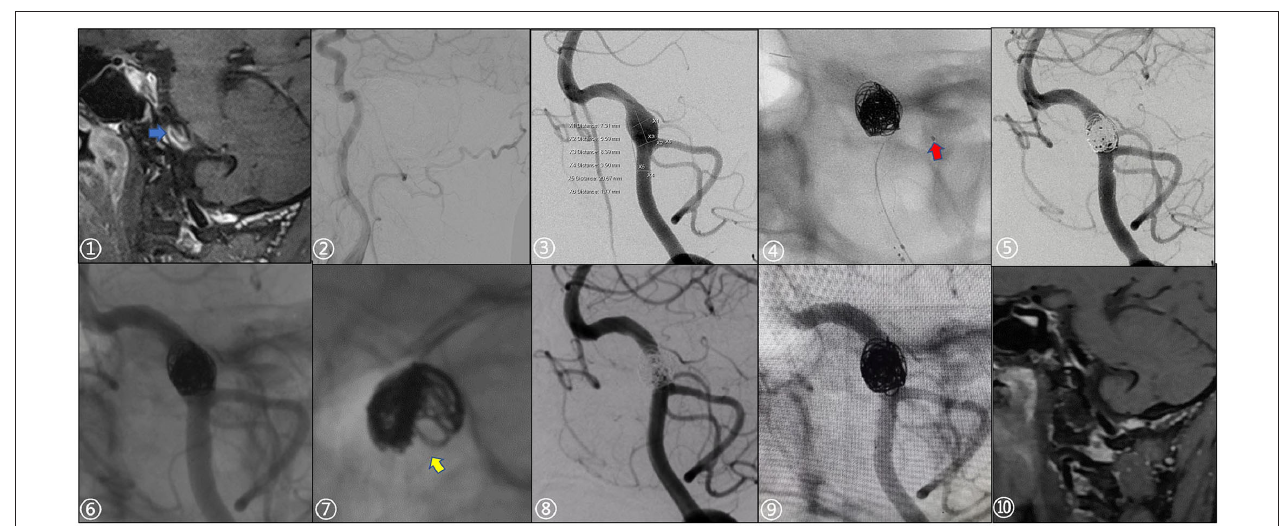
FIGURE 2 | A 49-year-old male patient presented with a sudden severe headache once 2 months prior. ‹ Preoperative high-resolution MRI showed significant enhancement of the vessel wall with the intraluminal slow flow (blue arrow). › Right vertebral artery dysplasia. fi Preoperative measurement of aneurysm and parent artery, aneurysm size: 7.31 x 8.39mm. fl Echelon-10 microcatheter (red arrow) was used to protect the posterior inferior cerebellar artery during operation. (cid:176) , – Stents were post-deployed, Immediate postoperative angiography and non-subtraction images showed slight stagnation in the aneurysm sac (Raymond IIIa; Microplex-10 coils: two 8 x 30cm and one 7 x 30cm; LVIS stents: 4.5 x 20mm, 4.5 x 15mm). † The distribution of the coils along the wall was not well-uniform. ‡ , · 12-month follow-up showed that there was no recurrence of the aneurysm (Raymond I) and the parent artery was patent. (cid:181) 12-month follow-up with HR-MRI,